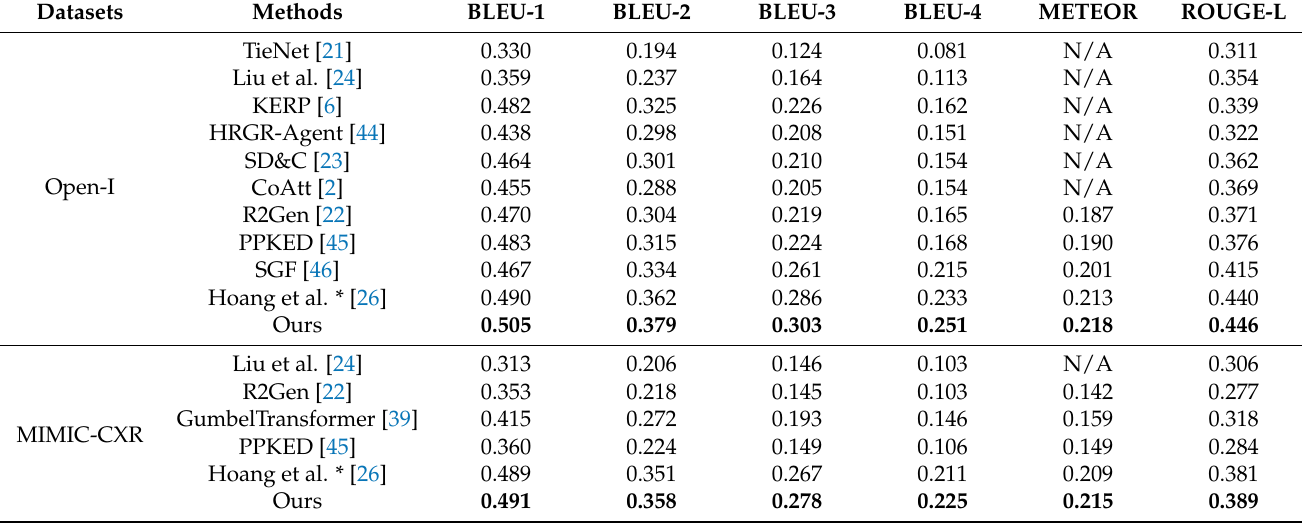
Table 1. A comparison of our method and many existing methods, using different linguistic metrics: BLEU-1 to BLEU-4, METEOR, and ROUGE-L, with the best results highlighted in